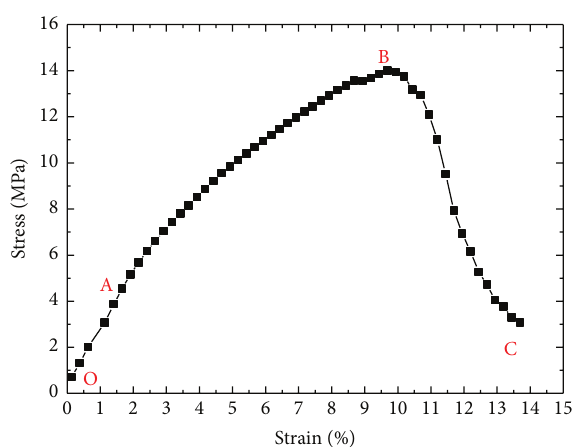
Figure 5: Typical tensile stress-strain curve of an oriented linear porous metal sample.